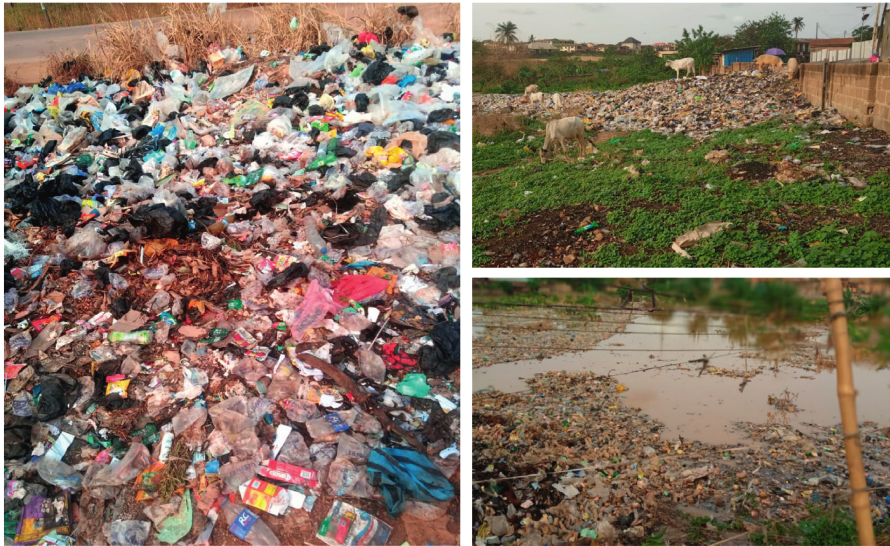
Figure 1: Picture of the open dumping site at Nguzu Edda.